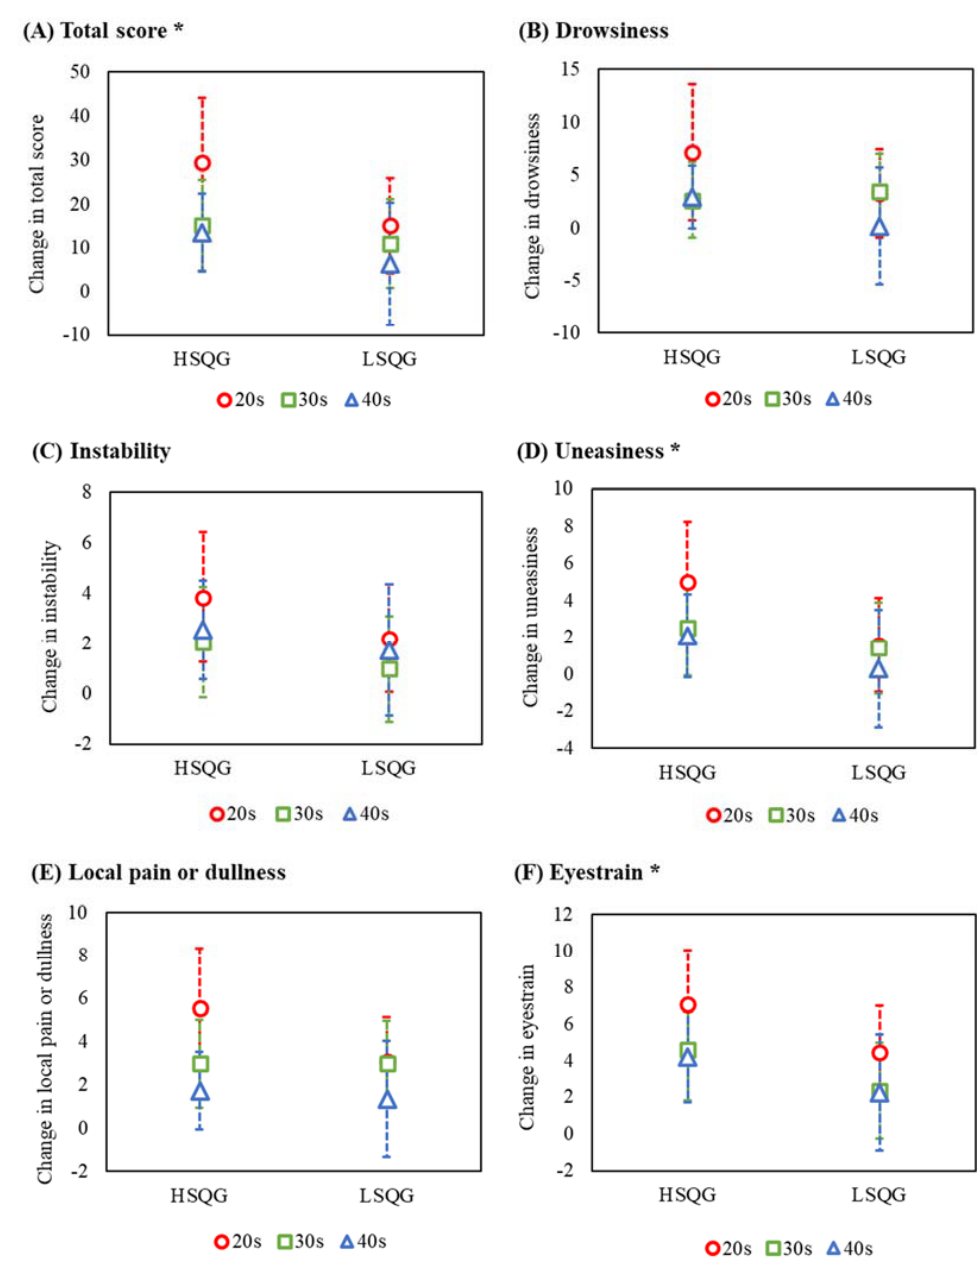
Figure 3. Comparison by cluster of change in fatigue after the night shift to the morning of the next